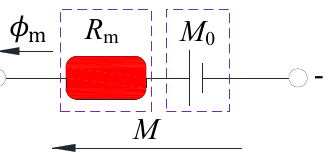
Figure 6. The equivalent magnetic circuit model of the permanent magnet.